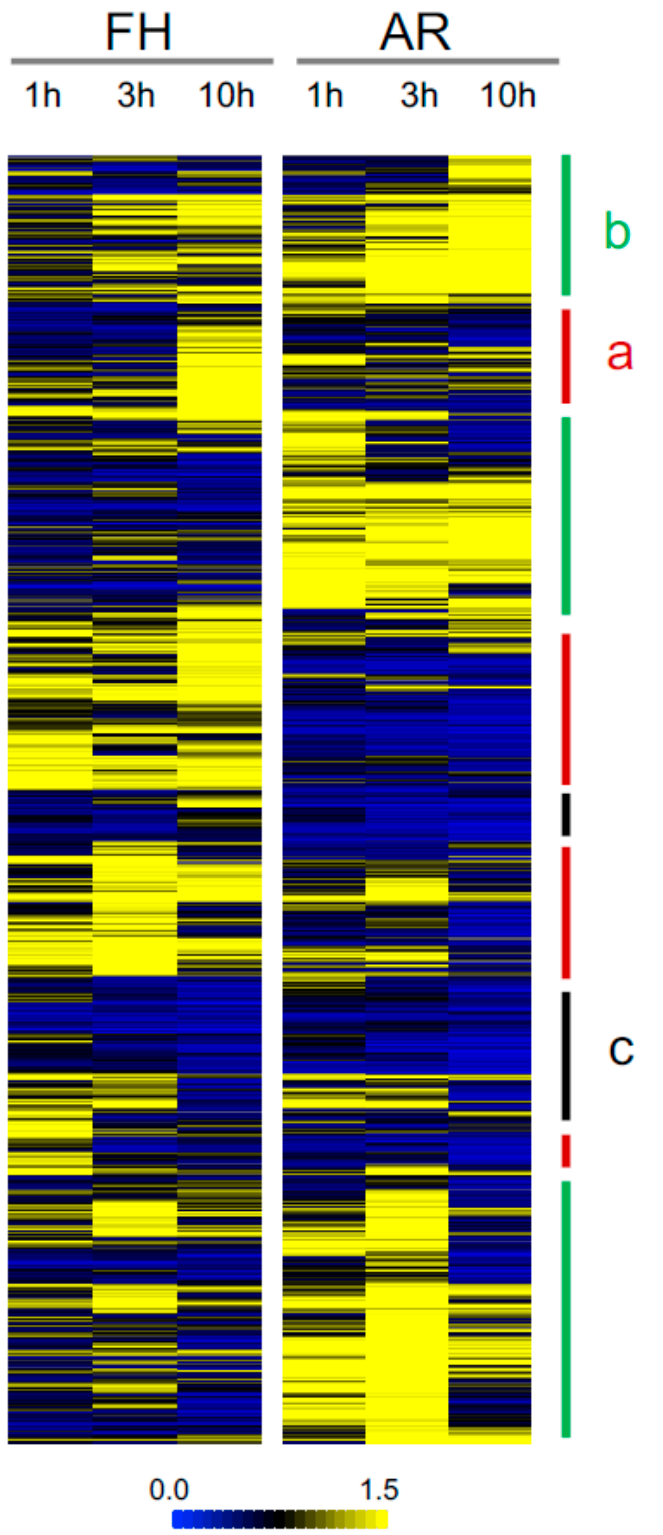
Figure 2. Comparative analysis of FH and AR barley grains. Quantitative data of each phosphopeptide in FH and AR grains was displayed as a heatmap. Phosphopeptides could be classified into clusters a, b and c based on their phosphorylation patterns. Cluster a (red) and cluster b (green) include phosphopeptides primarily showing large increases in FH and AR grains, respectively. The cluster c (black) includes phosphopeptides that showed similar tendencies in both